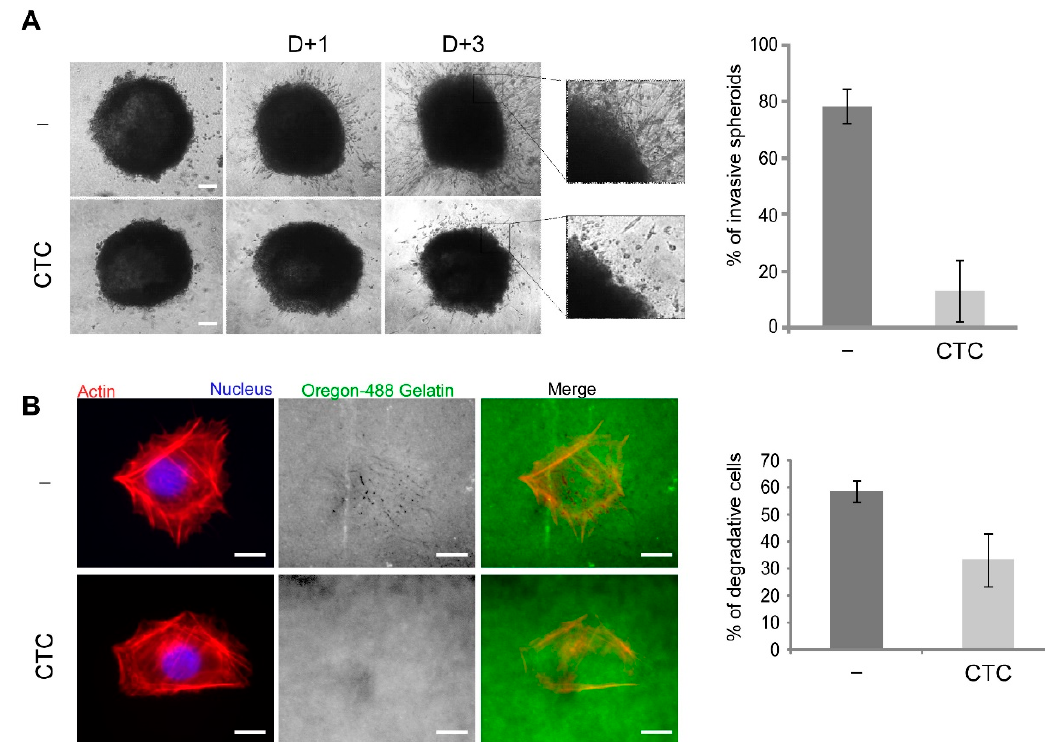
Figure 7 . CTC inhibits MDA-MB-231 cell invasion and matrix degradation properties. ( A ) Spheroid formation of MDA-MB-231 cells in collagen was monitored for 3 days with or without CTC (100 µ M). The graph (right panel) represents the % of invasive spheroids estimated after 3 days (n = 100 per experiment) compared to t = 0 from 3 independent experiments performed in quadruplicates. The mean is represented ± SD. Scale bar 100 µ m. ( B ) Representative images of MDA-MB-231 placed in Oregon-488 gelatin (green) coated coverslips and stained for F-actin (red) and nuclei (blue). Areas devoid of fluorescent signal indicate degradation of the fluorescent gelatin. Scale bars 10 µ m. Quantification of degrading cells (right panel). Values are percentages of degrading cells, in which 100 cells per condition were analyzed. n = 3, Student’s t -test, * p < 0.05.